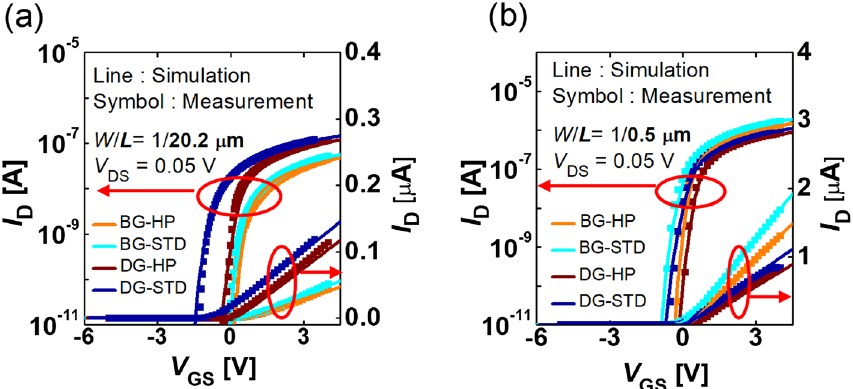
Figure 7. The TCAD simulation (line) vs. the measurement data (symbol). ( a ) I–V curve at W / L = 1/20.2 μm, and ( b ) I–V curve at W / L = 1/0.5